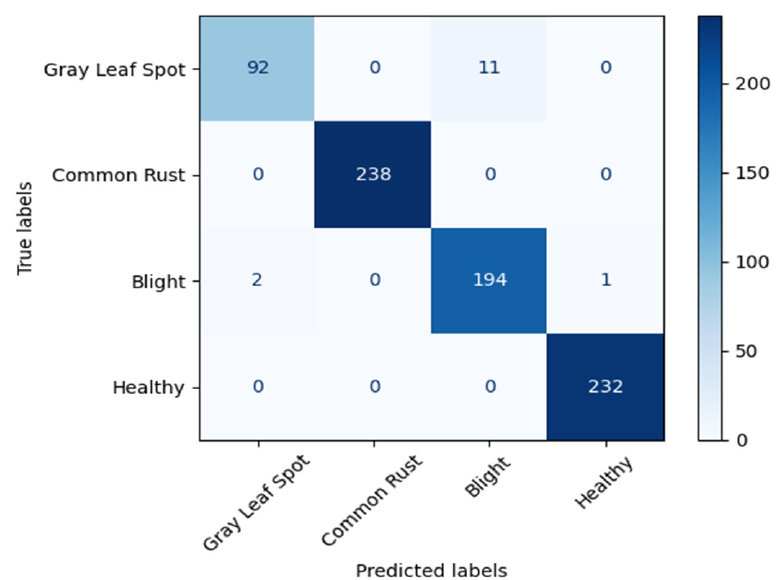
Figure 9. Confusion matrix of the PCENet with 25% filter reduction.